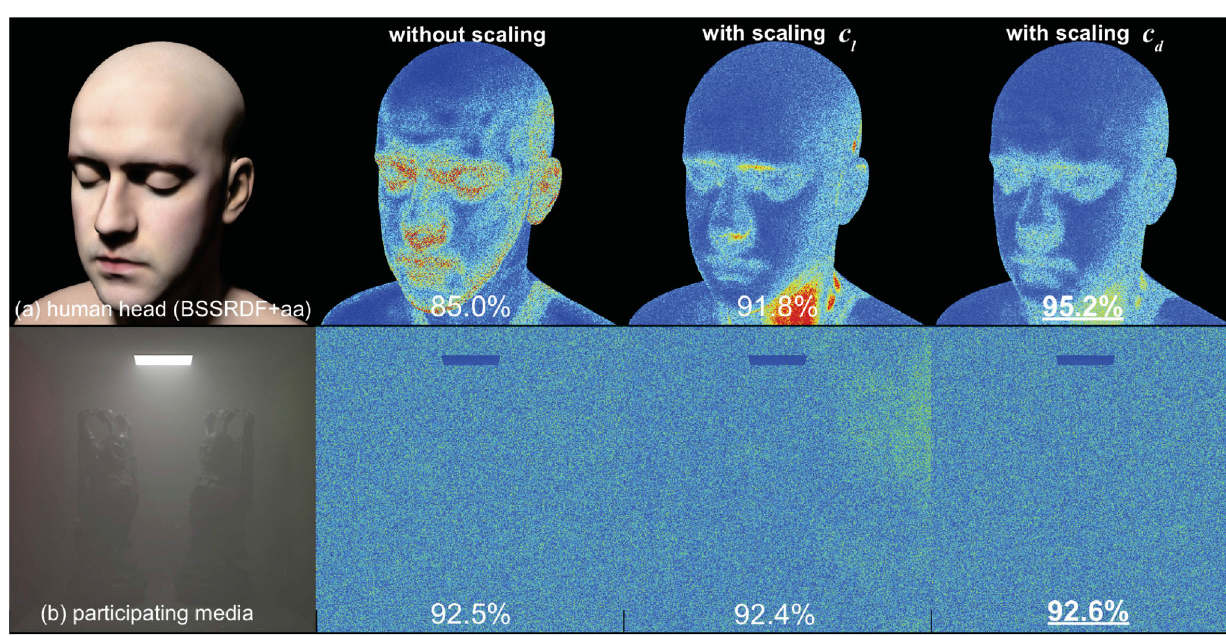
Fig. 10 Cluster selection without scaling (the second column), with scaling by c l (the third column), and scaling by c d (the fourth column) for subsurface scattering (above) and participating media (below). Although scaling by c l provides better estimation accuracy R (cid:2) than not scaling in the human head scene (above), relative errors greater than 5% can be seen in the neck. Scaling using c d provides the best estimation accuracy and relative errors greater than 5% are not seen. In the Cornell-box scene with homogeneous participating media (below), since VPLs and shading points are distributed throughout the scene, the improvements due to the use of c d are subtle, but its use does not impair the estimation